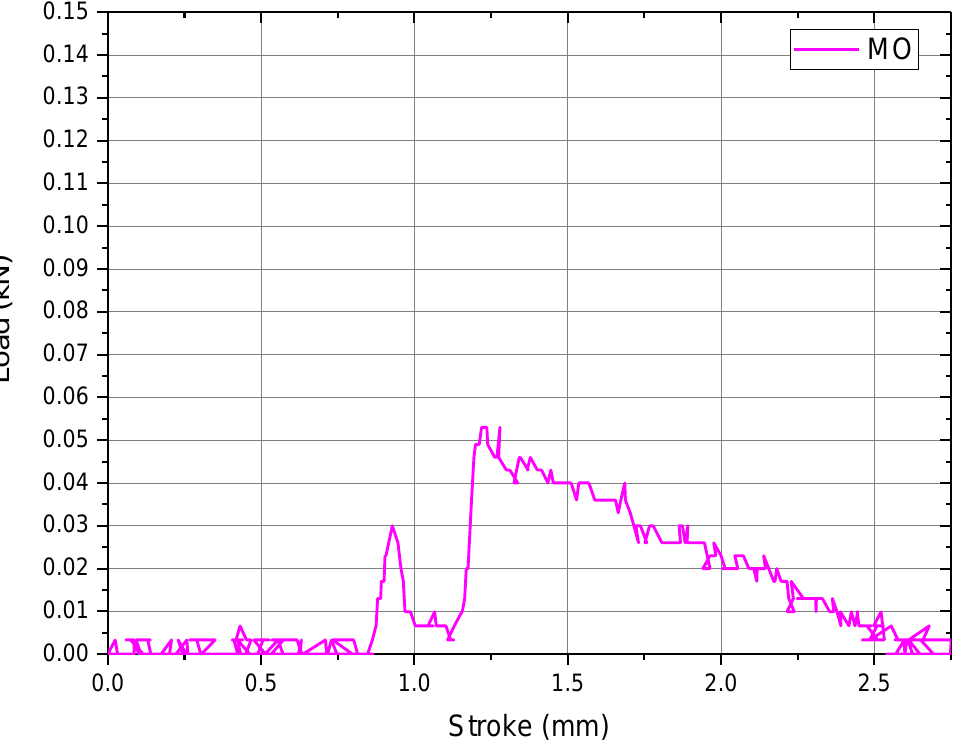
Figure 6. Load chart for pull off testing on CoCrFeNiMo 0.85 high-entropy alloy coating. The load chart presents the elastic behavior and the failure point for the epoxy resin